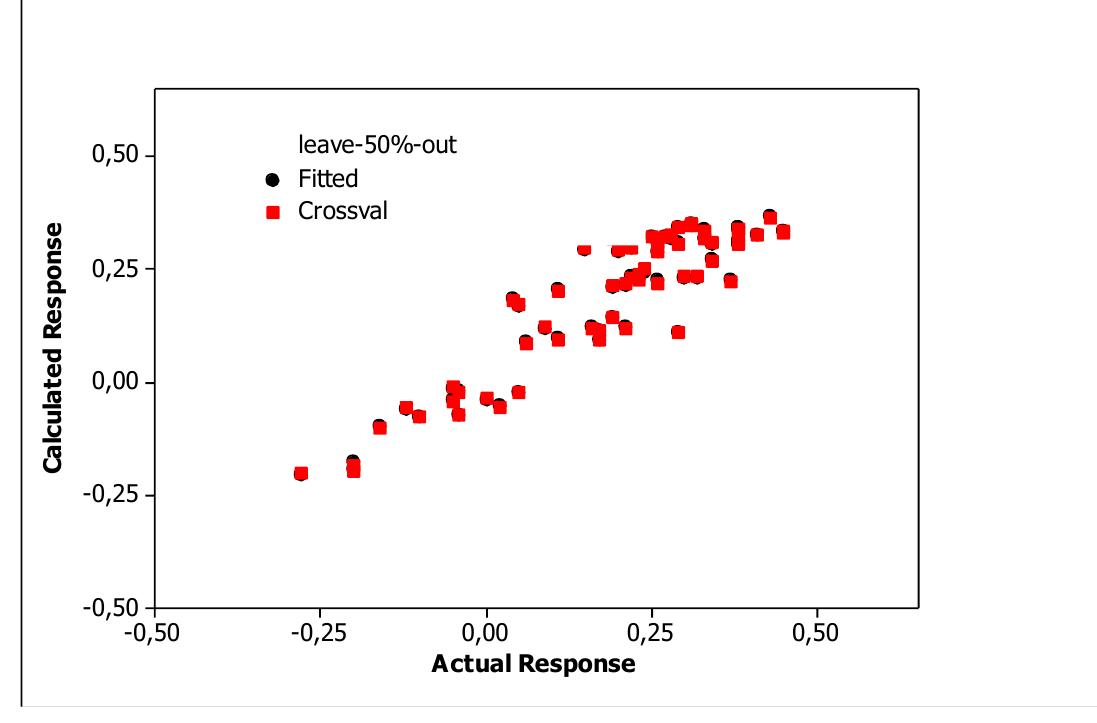
Figure 5. PLS response plots obtained for Equation (12).